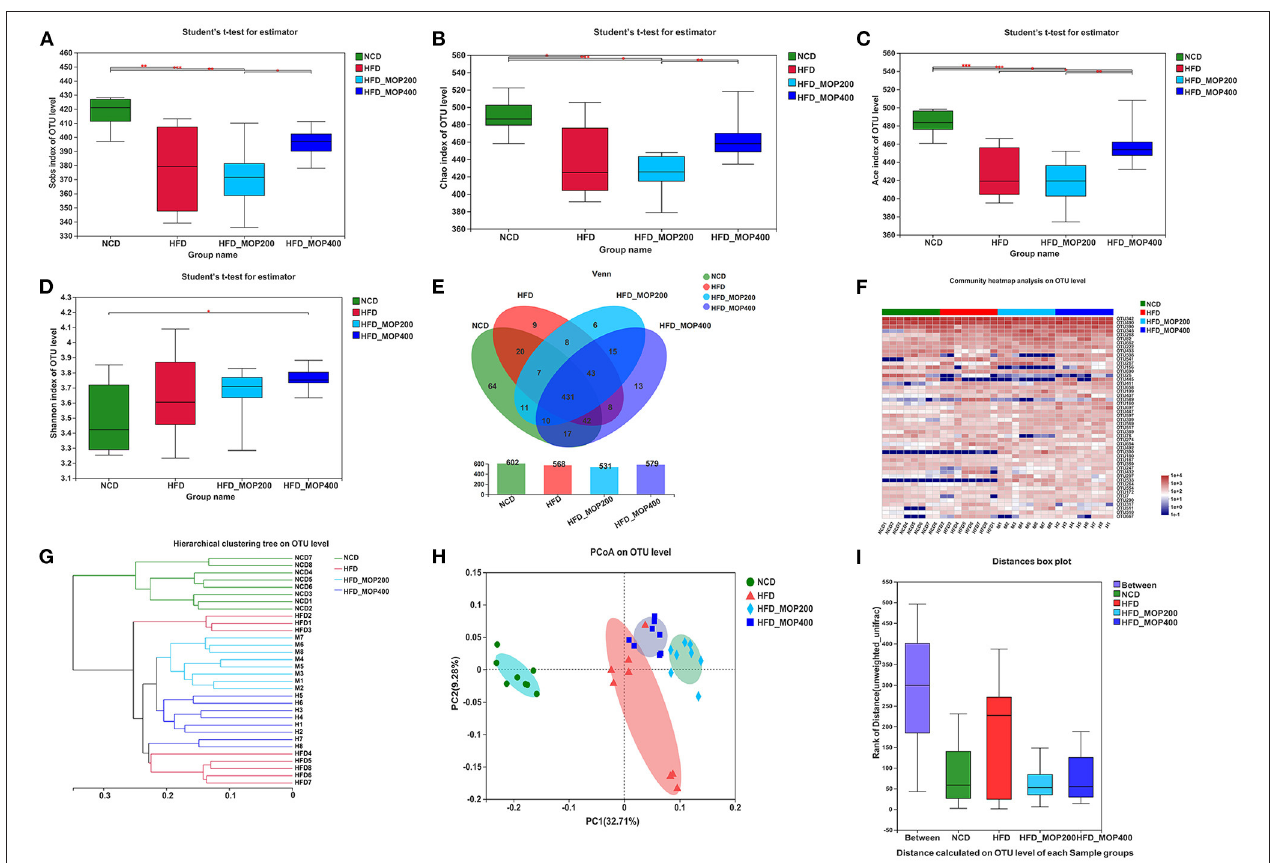
FIGURE 6 | MOP alters the diversity and composition of the gut microbiota in HFD-fed mice ( n = 8 mice/group). (A–D) Sobs index, Chao index, ACE index, and Shannon index, respectively; (E) Venn diagrams that illustrated the observed overlap of OTUs; (F) Heatmap of top 50 OTUs; (G) Hierarchical clustering dendrograms of all samples based on unweighted UniFrac distance; (H) PCoA plot of unweighted UniFrac distance; (I) Analysis of similarity (ANOSIM) using bray-curtis distance at OTU level. The data are expressed as mean ± SD. Bars marked with different superscript letters (a-c) indicate significant differences at p < 0.05 based on one-way ANOVA with Duncan’s post-hoc